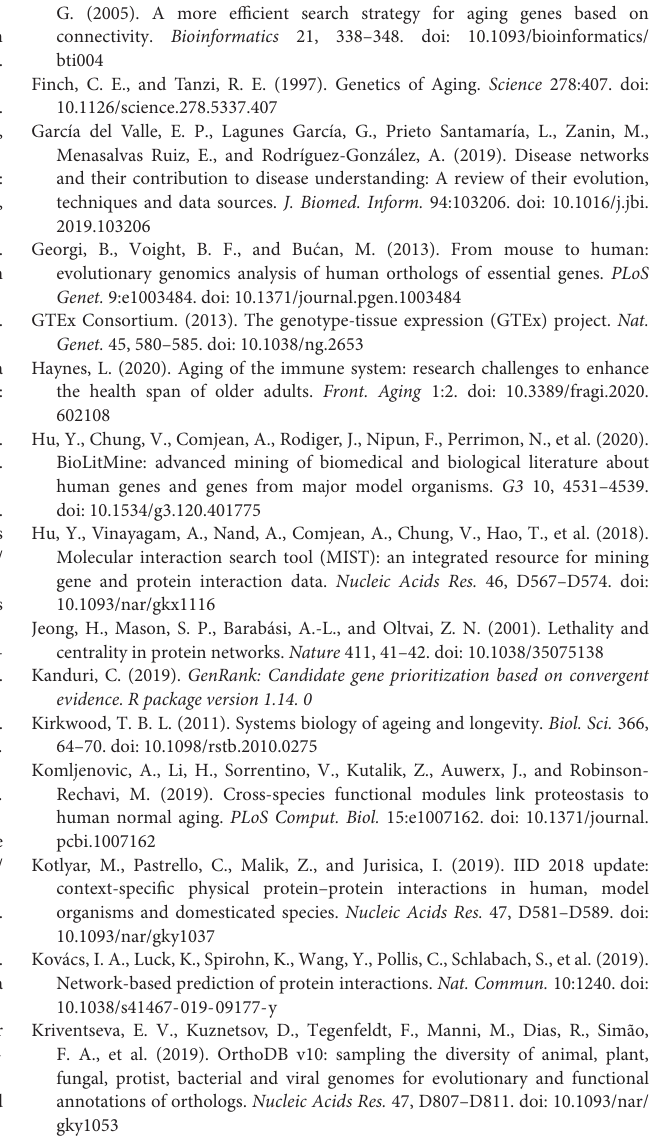
longevity related genes (human) and orthologs (mice, flies, worms) in corresponding protein interactomes. The Y axis provides the ranking order based on the Convergent Evidence Score (CES) of the 1007 genes. The node size indicates the number of degree associated with a gene in the corresponding PPIN. The node color represents the designated status of the gene as drug target (1 – mapped and 0 – No mapped) for the longevity associated drugs. Supplementary Figure 8 | Potential candidates in cross-species longevity drug-targets interaction network. Species-specific targets for the drugs like rapamycin, melatonin, and metformin were represent through an interactive drug-target interaction network. The color of the nodes represents different species like purple (human), yellow (mice), green (flies) and red (worm). The shape of the nodes indicates – targets (round) and drugs (square). Share common targets of those drugs in human PPIN were highlighted, including MTOR, IRS1, IL2, and